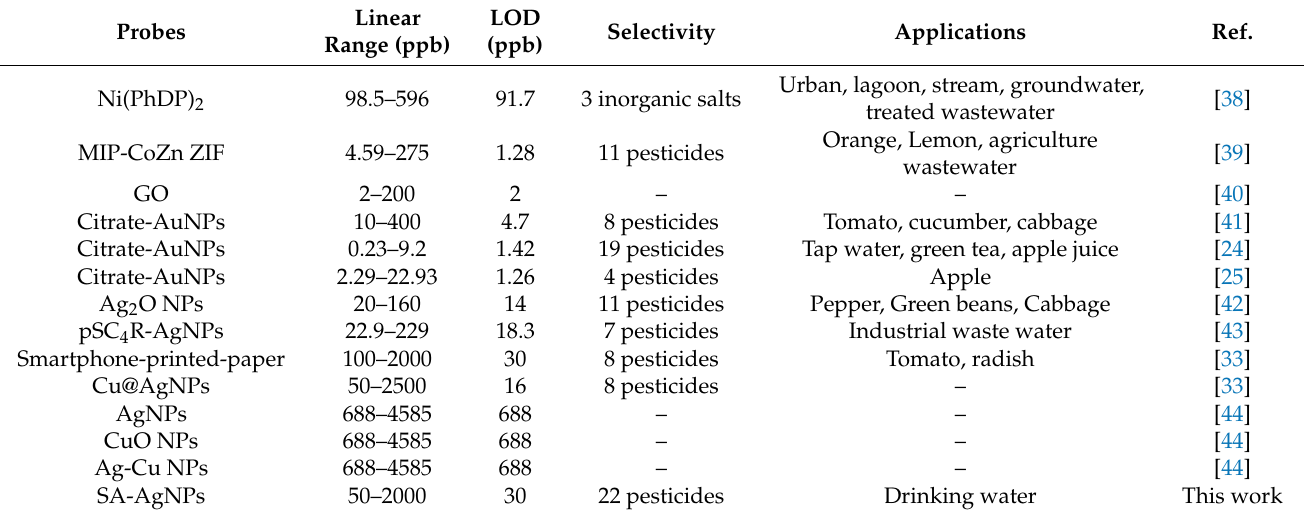
Table 1. Comparison of the proposed assay with other reported assays for the colorimetric detec- tion of dimethoate.